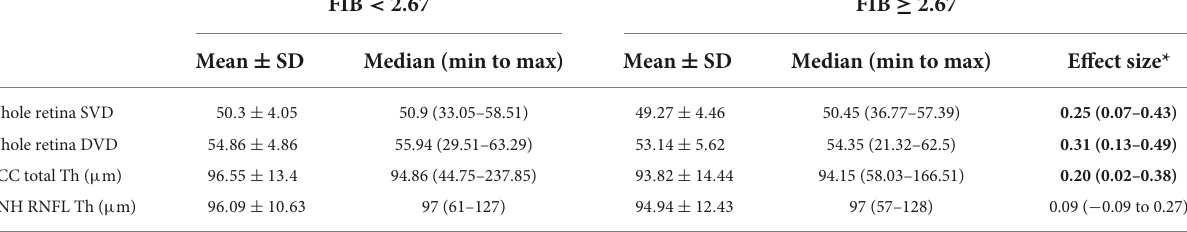
TABLE 3 Description of the whole sample at ophthalmological